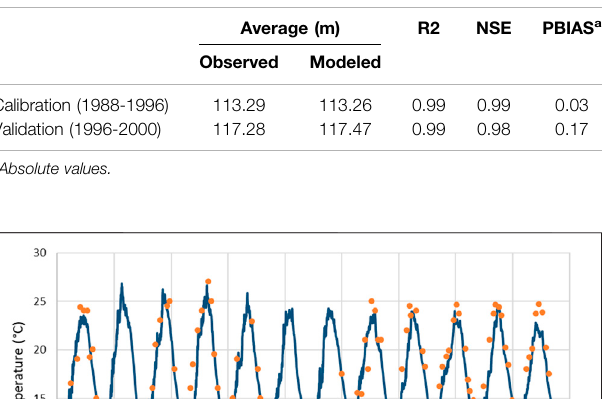
TABLE 2 | Statistical analysis for water level data.